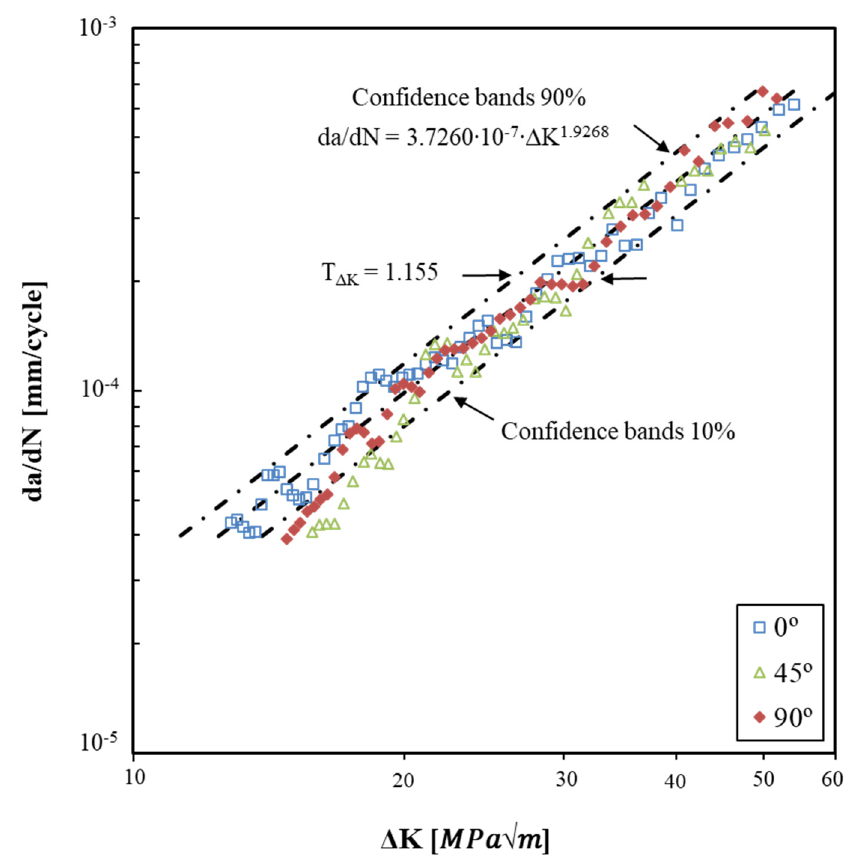
Figure 6. da/dN curves for β = 0°, β = 45° and β = 90°, R = 0.05.